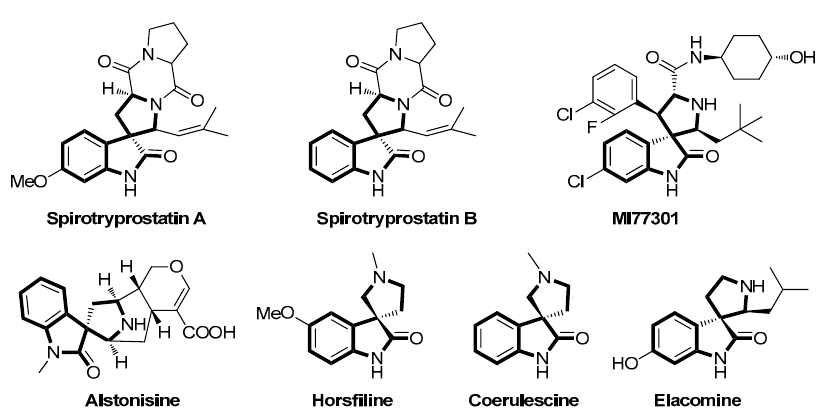
Figure 1. Examples of the spirooxindole-pyrrolidine framework in biologically active molecules.